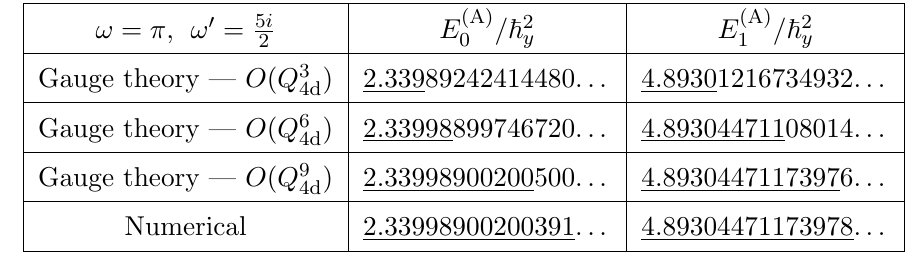
p 5 ~ y . The spectrum is the same as the one in